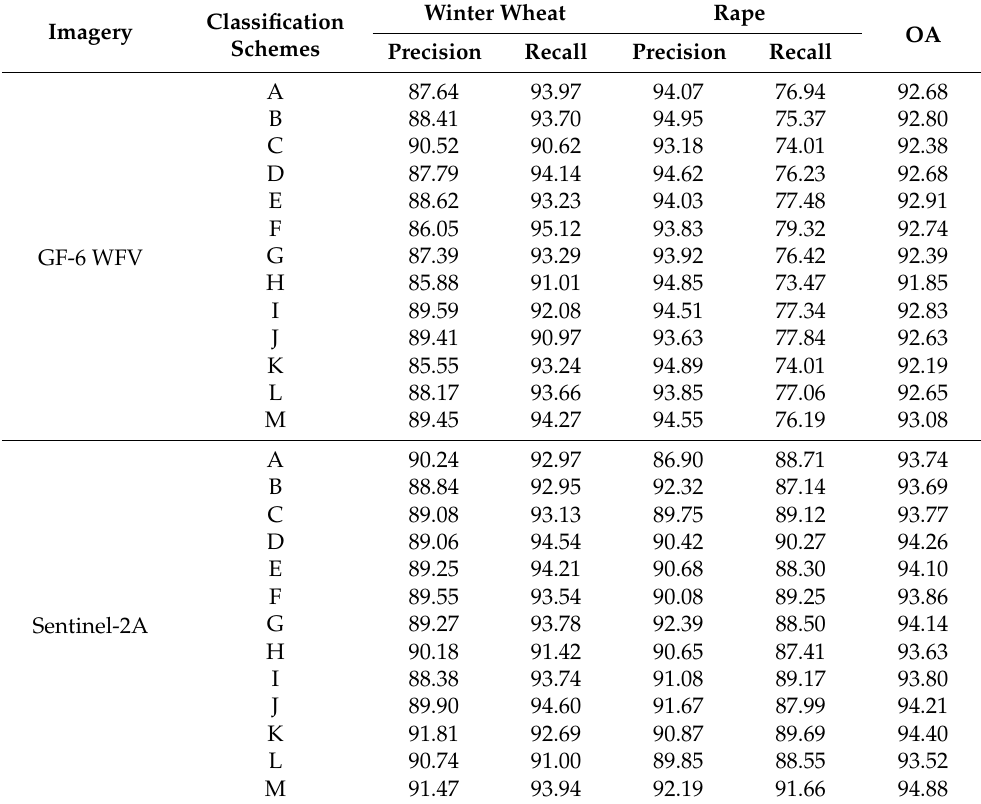
Table 11. Results of accuracy evaluation of GF-6 WFV and Sentinel-2A data with different combina- tions of spectral